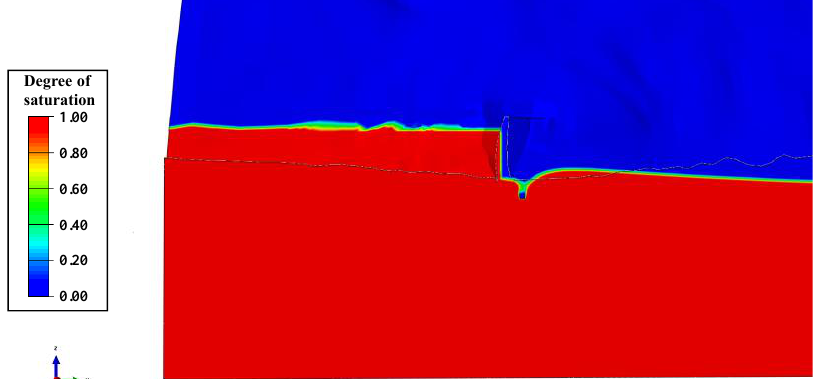
Figure 24. Numerical calculation results of the saturation degree of the second stage of the arch dam’s spillway section (water level: 1800 m).